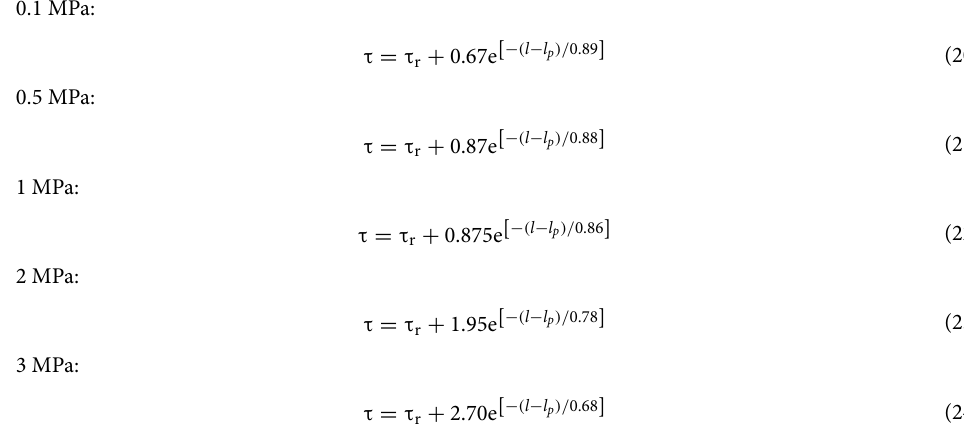
where τ r is the residual shear stress, l p is the shear displacement corresponding to the peak point of the shear stress, l is the shear displacement, and A and B are the fitting coefficients. According to Fig. 10, the fitting equations for the structural plane with an initial undulant angle of 30° under different normal stresses are as